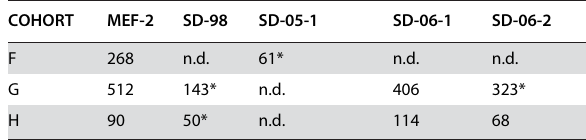
* p , 0.05 n.d.=not done doi:10.1371/journal.pone.0000069.t003 .